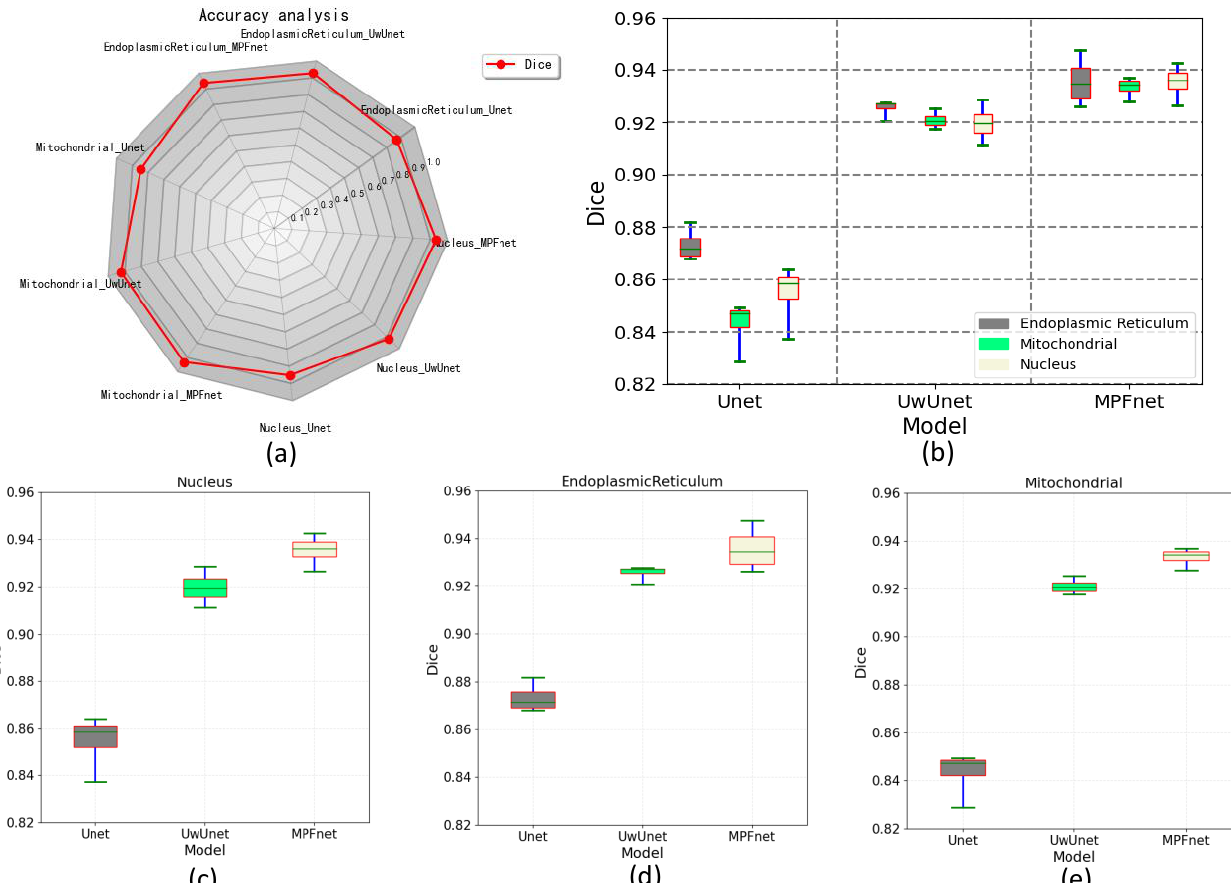
Figure 5. Comparing dice performance among various prediction algorithms. ( a ) Dice similarity coefficient radar chart for quantitative comparisons of different predictive models. ( b ) Box plot of dice values for all organelles (nuclei, mitochondria, and endoplasmic reticulum) prediction task set with MPFnet-based learning model and compared with that of varied deep neural network-based prediction models, such as Unet and UwUnet learning model on all. ( c ) Box plot of dice coefficient value on nuclei prediction task set with MPFnet-based learning model and compared with that of varied deep neural network-based prediction models, such as Unet and UwUnet learning model. ( d ) Box plot of dice coefficient value on endoplasmic reticulum prediction task set with MPFnet-based learning model and compared with that of varied deep neural network-based prediction models, such as Unet and UwUnet learning model. ( e ) Box plot of dice values on mitochondria prediction task set with MPFnet-based learning model and compared with that of varied deep neural network-based prediction models, such as Unet and UwUnet learning model.